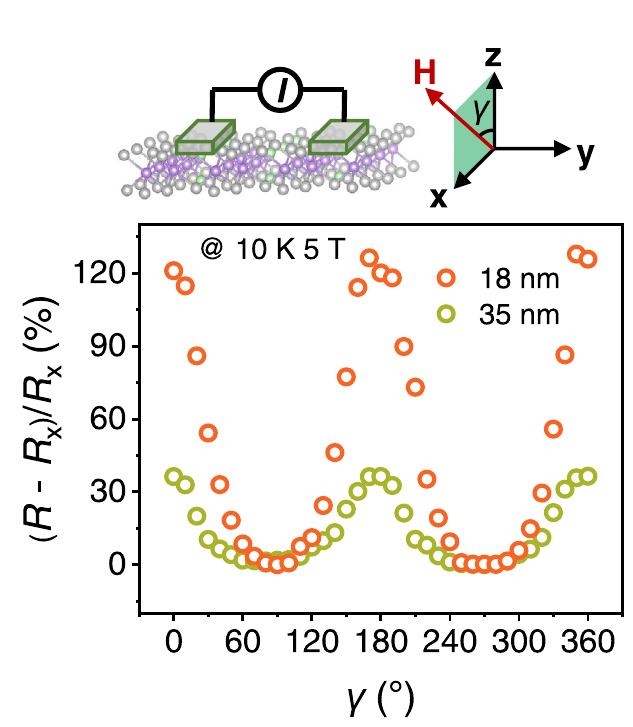
Fig.2|LocalMReffectinducedbygiantMBeffect. Theinsetsshowtheschematic and the de fi nition of azimuthal angles and directions of the